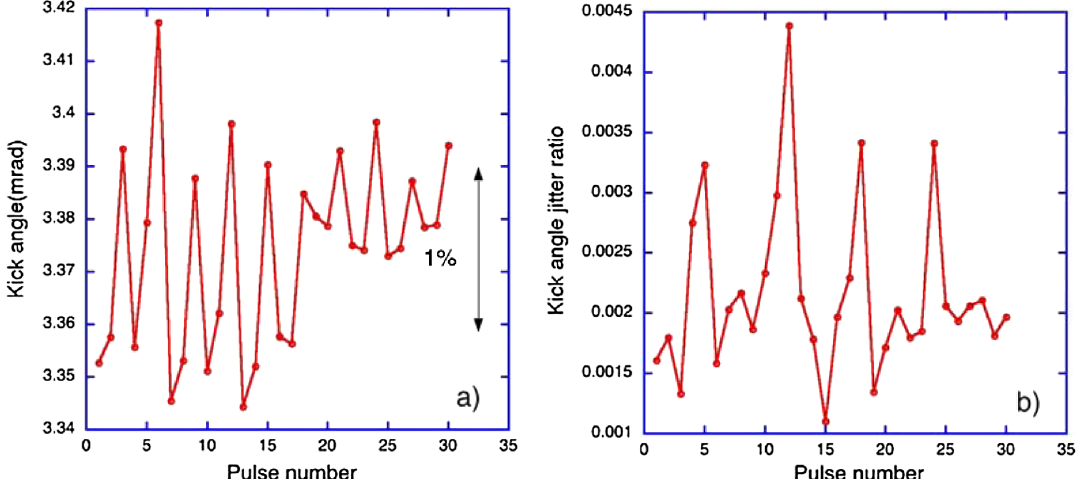
FIG. 14. (a) Kick angle as a function of the pulse number: The pulse-to-pulse variation of the kick angles of successive pulses is around 1%. (b) Kick angle jitter ratio as a function of the pulse number: The jitter ratio for the kick angle was distributed from 1 (cid:1) 10 (cid:2) 3 to 4 (cid:1) 10 (cid:2) 3 .